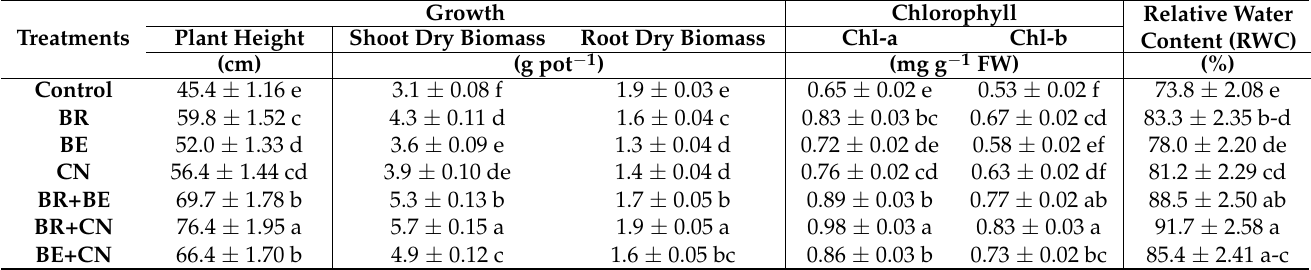
Table 2. The influences of BR, BE, and CN on growth and biomass, chlorophyll contents, and RWC in leaves of lentil grown on a Ni-affected soil are illustrated. Values characterized by the same letter are not significantly different at the α = 0.05 level. These values are the mean of three replicates ±